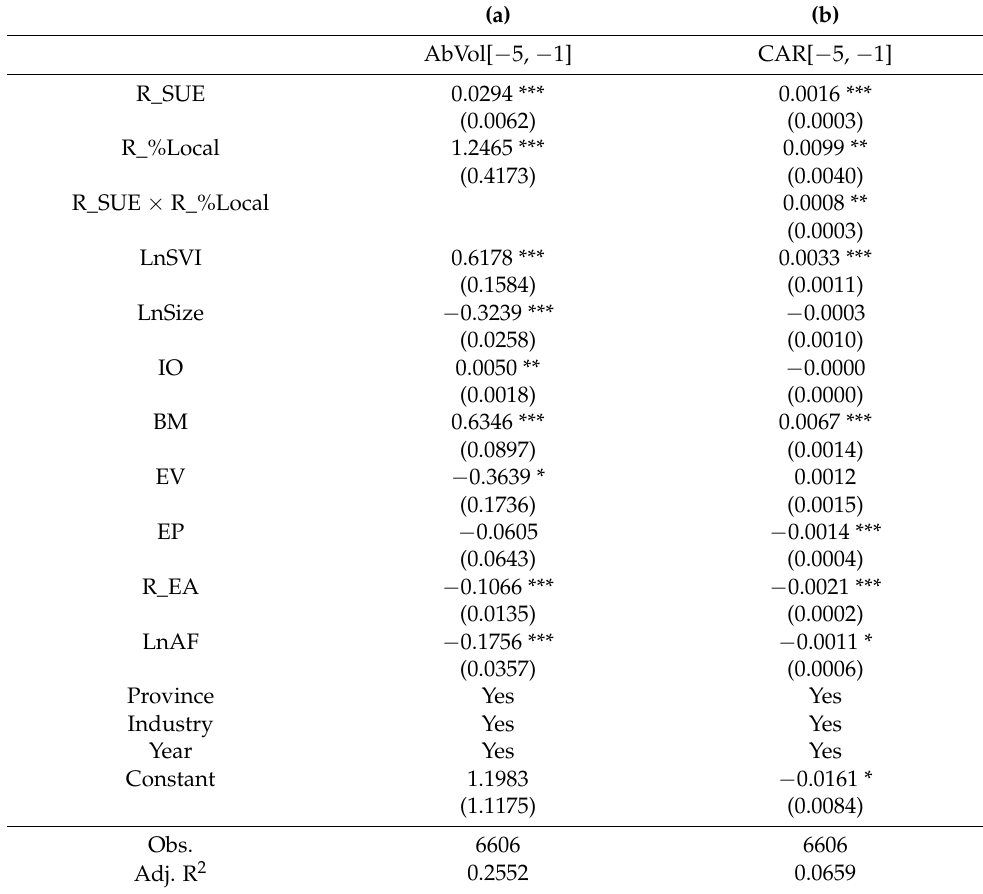
Table 6. Local Attention and Market Response before the Earnings